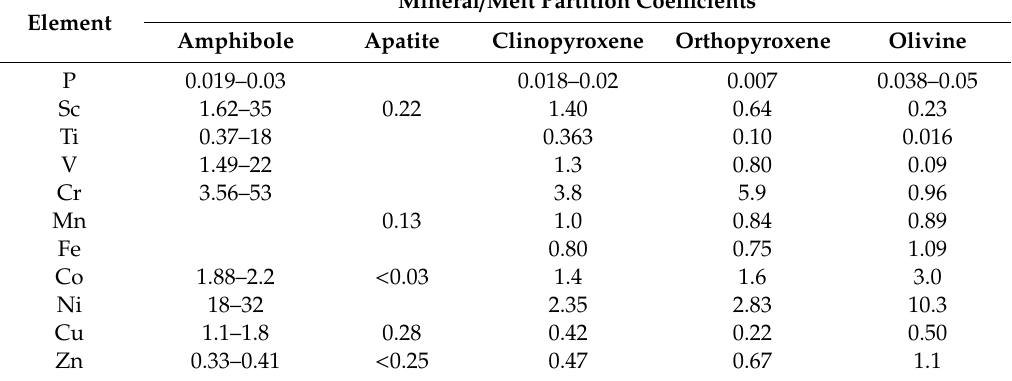
Table 4. Partition coefficients between mantle minerals and silicate liquid for phosphorus and first row transition elements. Amphibole partition coefficients are from [66,80]; phosphorus from [66] and apatite from [83]. Clinopyroxene, orthopyroxene and olivine data compiled by [23]. Element